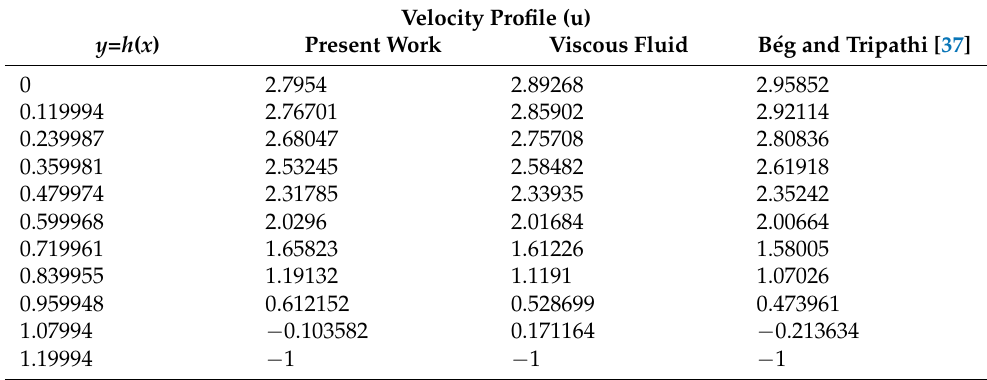
Table 1. A comparison between the present work and the available